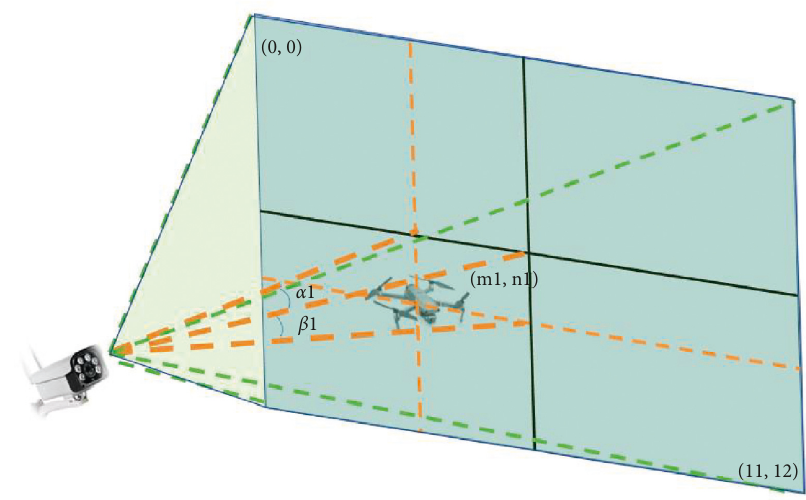
Figure 4: Locating the UAV using the photovoltaic